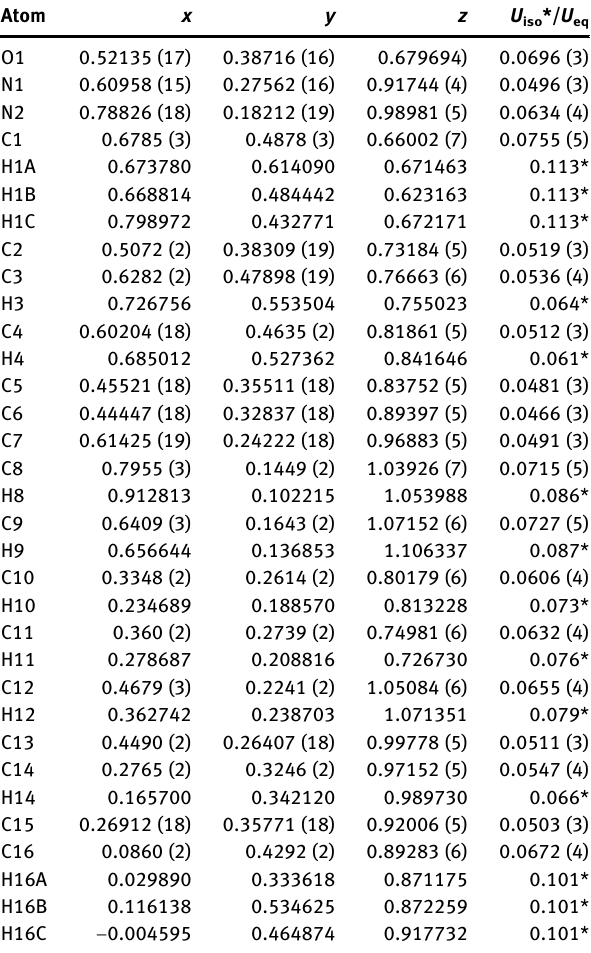
Table  : Fractional atomic coordinates and isotropic or equivalent isotropic displacement parameters (Å 